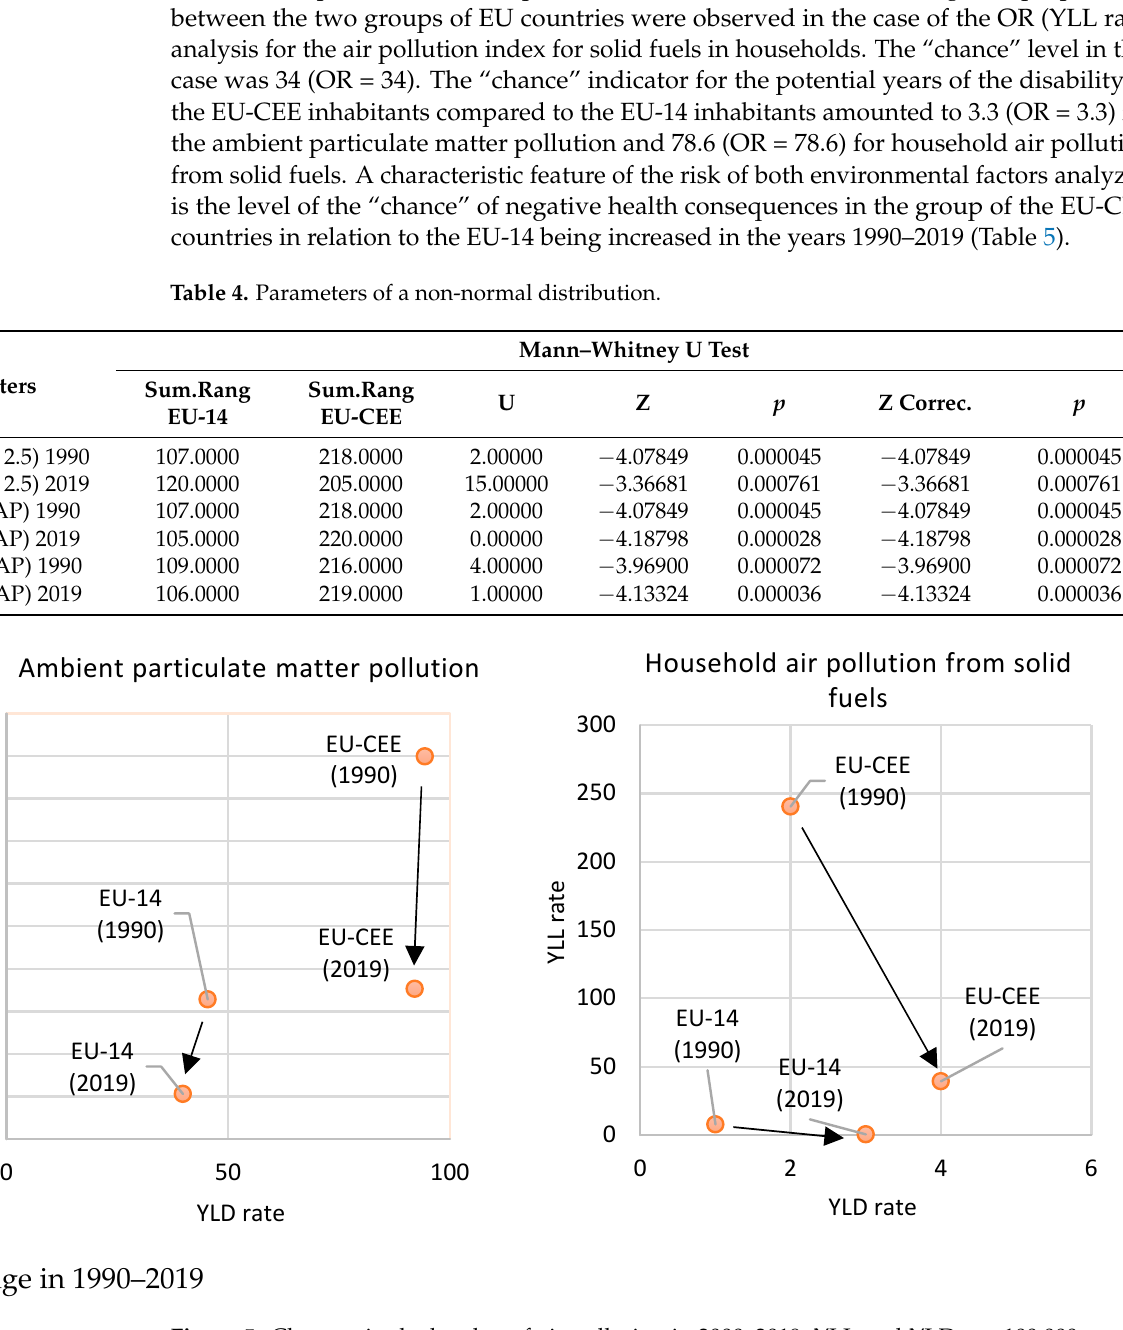
Figure 5. Changes in the burden of air pollution in 2000–2019, YLL and YLD per 100,000 people (groups of EU-27 countries).